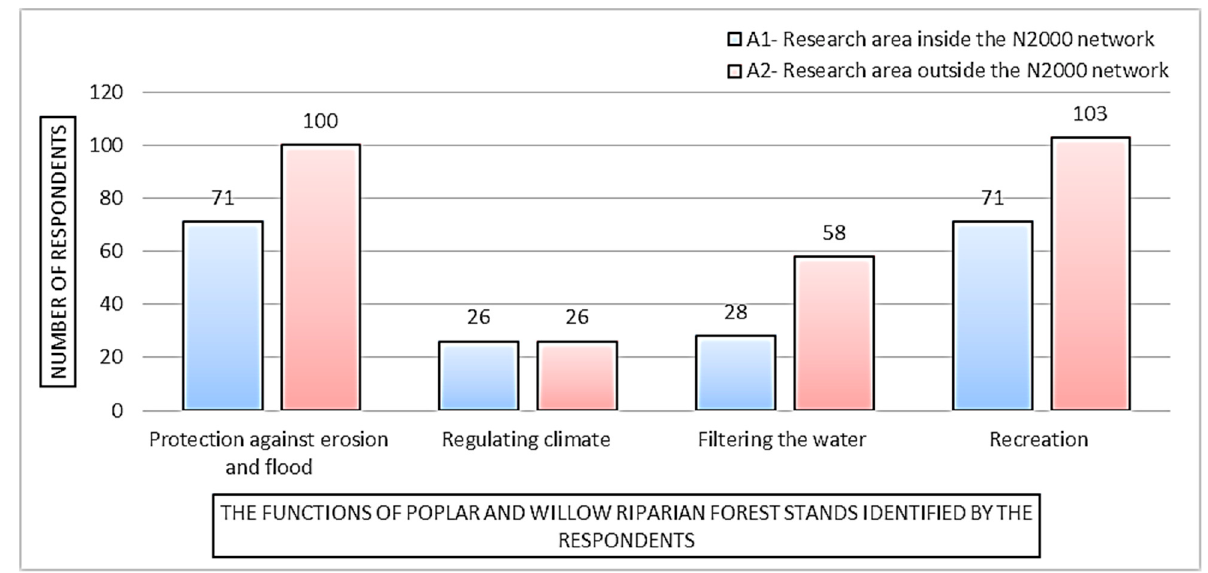
Figure 7. Local ecological knowledge regarding the ecosystem services provided by poplar and willow riparian forests.